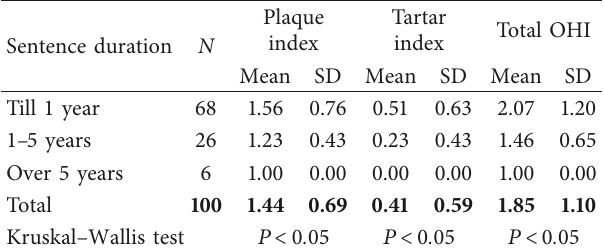
Table 8: Plaque and tartar index values according to the